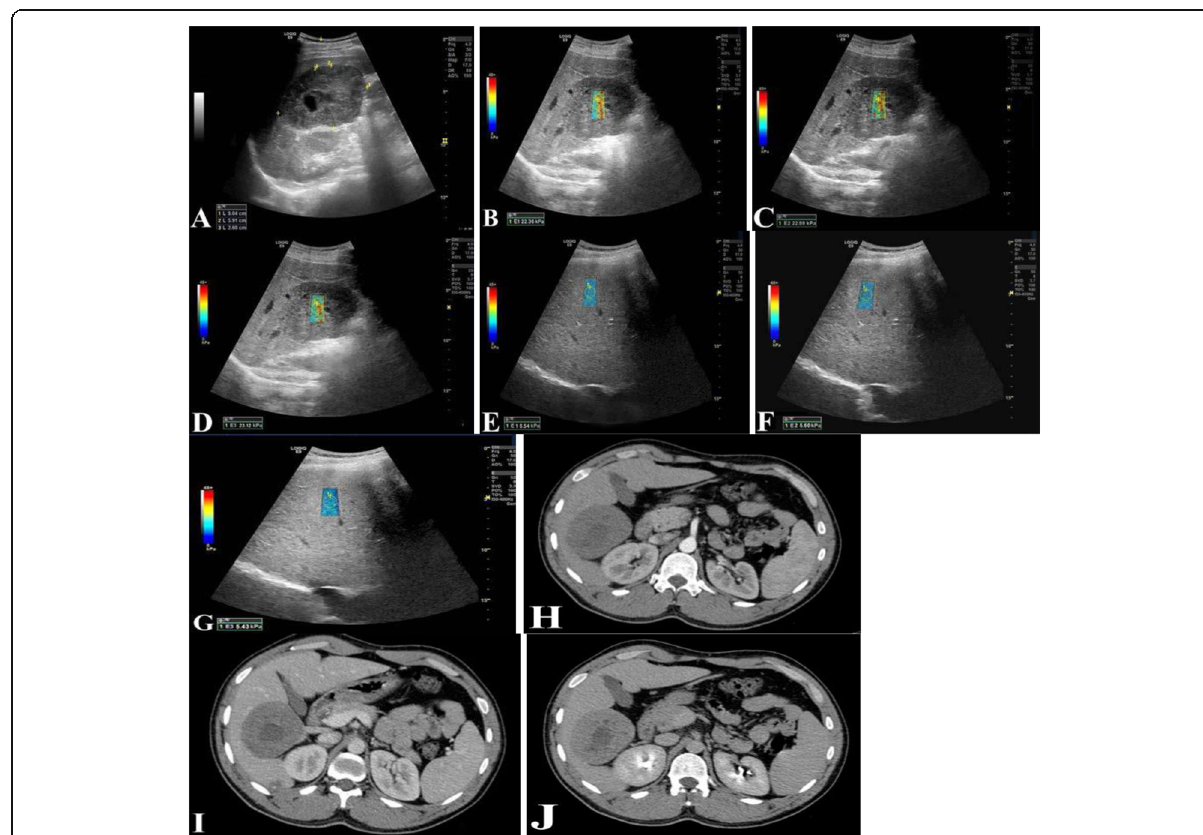
Fig. 5 Forty-four years old female patient with intestinal GIST seeking for metastatic work up. Imaging Findings: grey scale B-mode ultrasonography ( a ): normal sized liver with a well-defined hypoechoic focal lesion seen in segment VI measuring 9 × 5.9 cm with 2.6 cm depth from the skin. ϖ Color-coded shear wave sono-elastography: the lesion showed mixed color with red foci ( b , c , d ), while the liver parenchyma showed dark blue color ( e , f , g ). ϖ Shear wave sono-elastography stiffness values of the focal lesion: E1 = 22.36 kPa ( b ), E2 = 22.59 kPa ( c ), and E3 = 23.12 kPa ( d ). Calculated average stiffness value of the lesion = 22.69 kPa. ϖ Shear wave sono-elastography stiffness values of the parenchyma: E1 = 5.54 kPa ( e ), E2 = 5.60 kPa ( f ), and E3 = 5.43 kPa ( g ). Calculated average stiffness value of the parenchyma = 5.52 kPa. (cid:129)